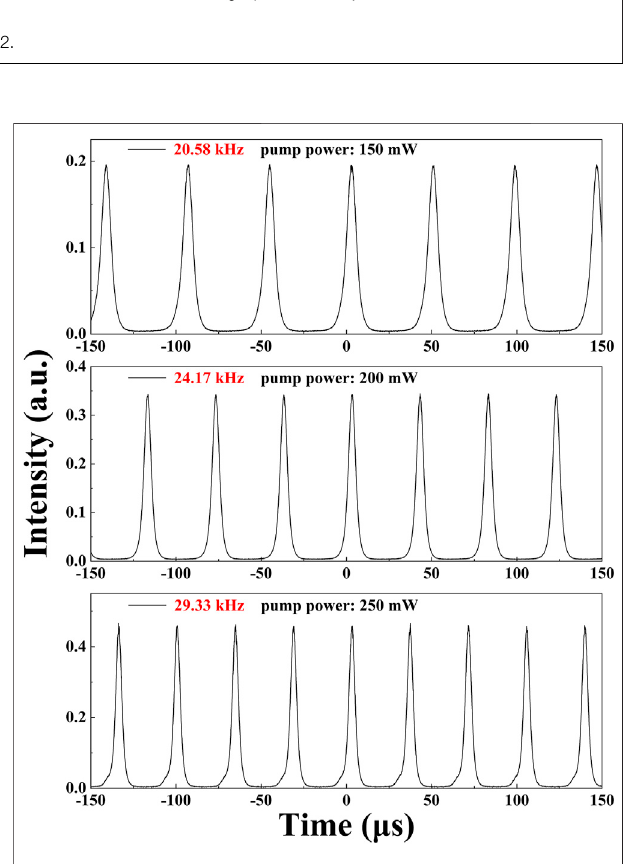
FIGURE 5 | The typical oscilloscope traces of the Q-switched pulse trains under different pump